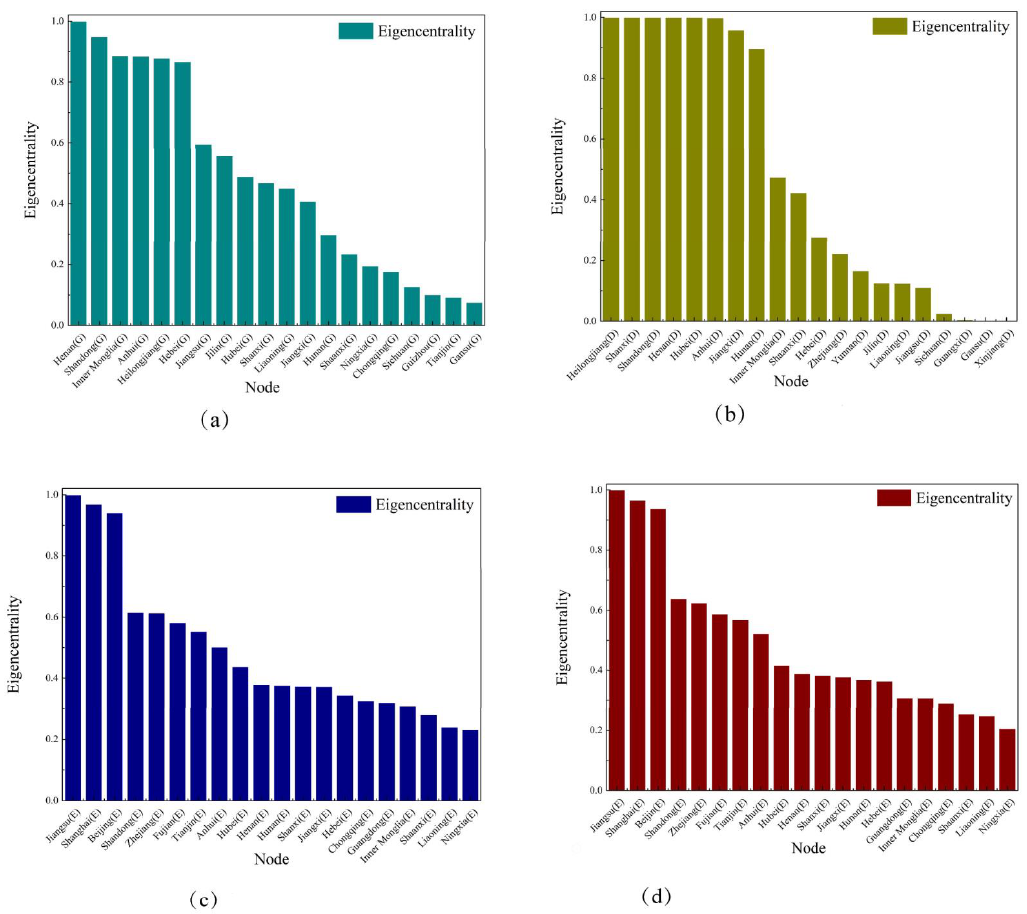
Figure 8. Top 20 nodes in terms of eigenvector centrality in the networks. ( a ) Grain layer; ( b ) Disaster layer; ( c ) Economy layer; ( d ) The grain-disaster-economy multilayer. (The nodes with the top 20 by Eigenvector centrality values are selected in the corresponding network above).